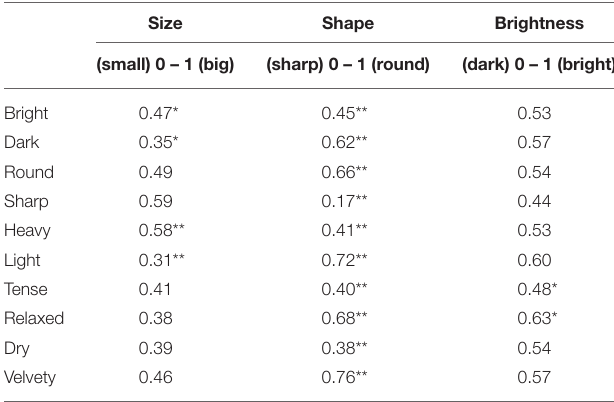
TABLE 5 | Mean judgment scores for size, shape, and brightness in the perception of 10 timbres.